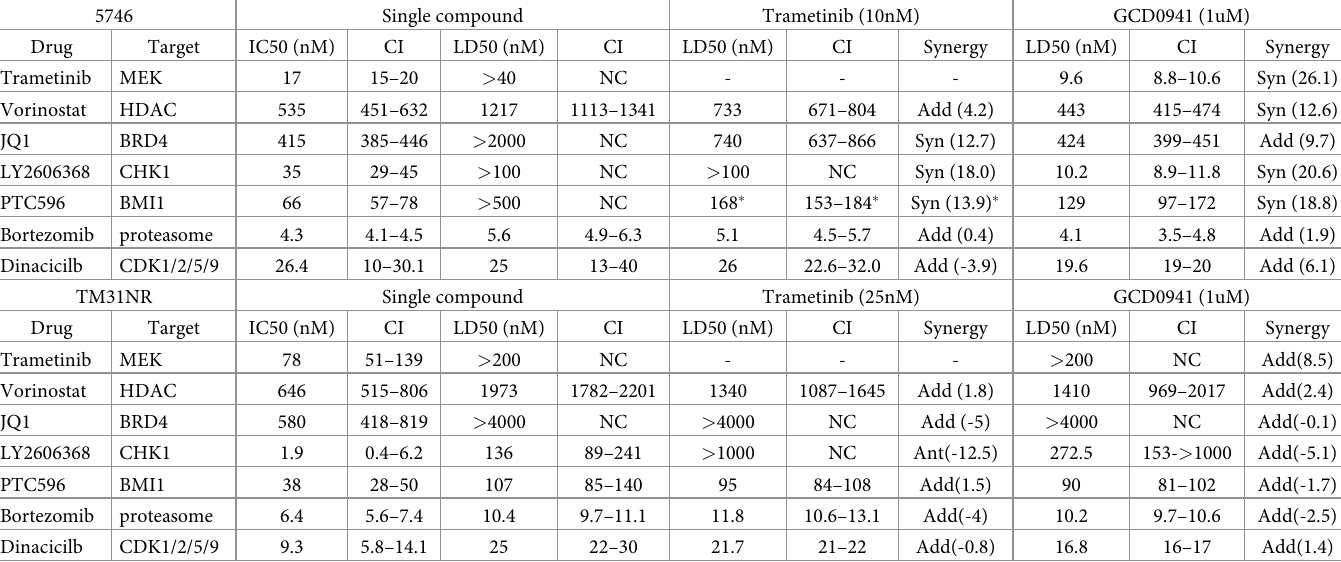
Table 1. Synergistic evaluations of drug combinations in 5746 and TM31 cell